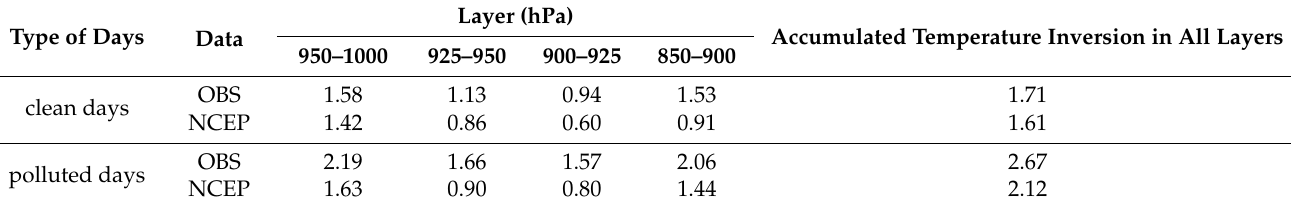
Table 6. Statistics for the temperature inversion (units: °C).